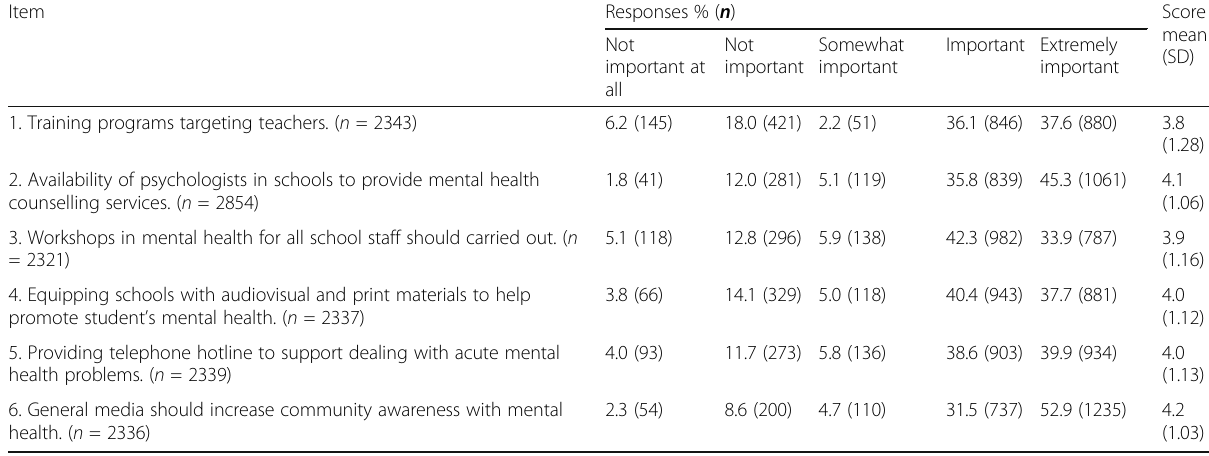
Table 5 Teachers ’ rating for the level of importance of proposed measures to promote awareness with mental health issues Item Responses % ( n